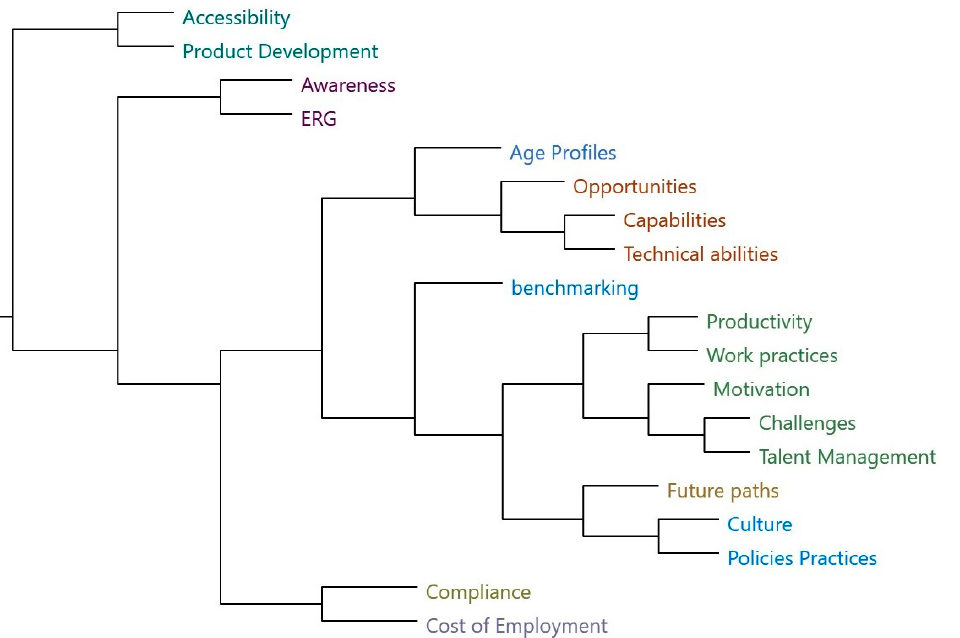
Figure 3. Word cluster analysis. “Policies and Practices” was the most referenced theme with 164 text references. “Ca- pabilities” was referenced 141 times, with “Talent Management” and “Awareness” refer- enced 80 and 55 times, respectively. The overall codebook (Table 3) illustrates the compo- nents of each theme and taken together, they provide an effective framework within which to evaluate findings. Table 3. Expanded codebook.